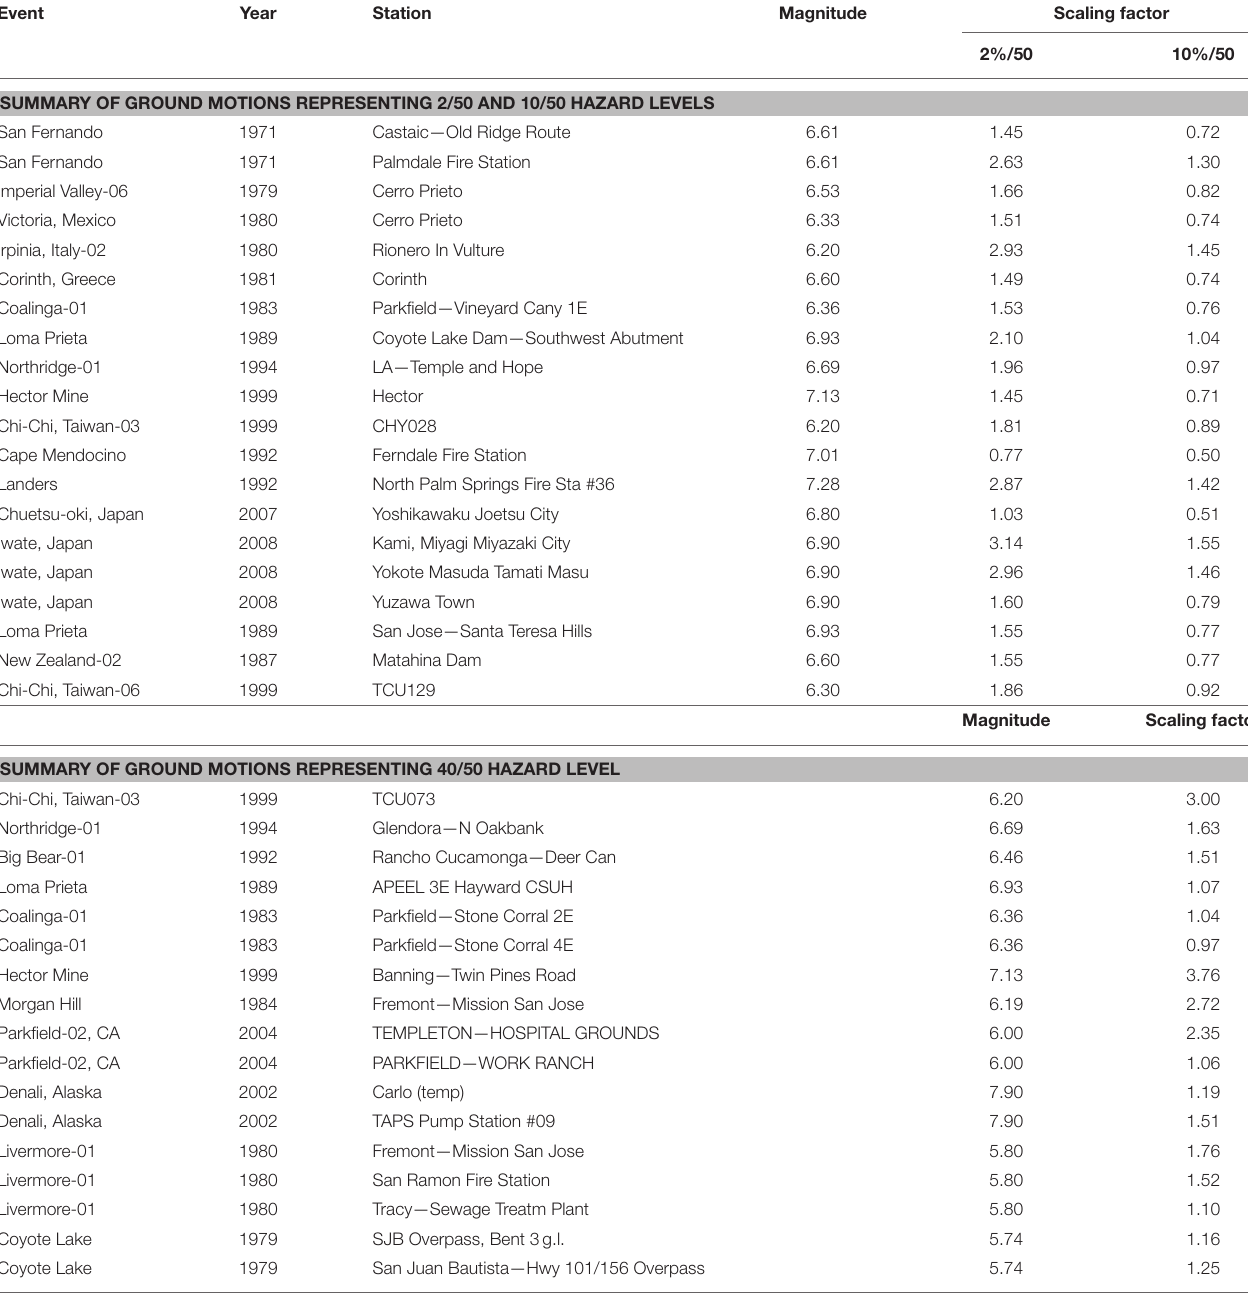
TABLE 3 | Summary of ground